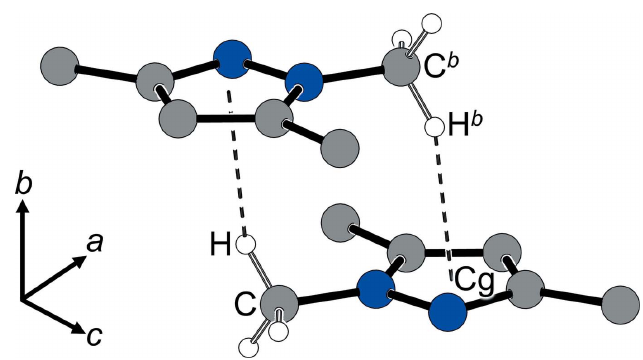
Figure 3 Short methyl C—H (cid:2)(cid:2)(cid:2) (cid:2) contacts about a center of inversion in 1 shown as dashed lines (Spek, 2020): d ( Cg (cid:2)(cid:2)(cid:2) H b ) = 2.586 A˚ ; / (C b —H b (cid:2)(cid:2)(cid:2) Cg ) = 140.97 (cid:4) . Symmetry code: ( b ) 1 (cid:5) x , (cid:5) y , 1 (cid:5) z